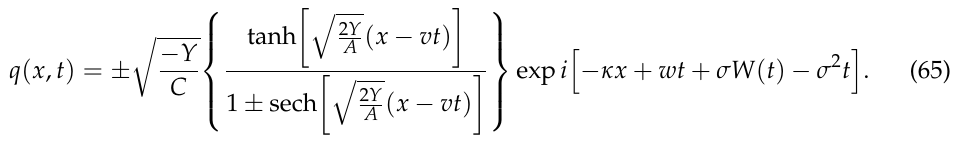
Figure 1: The numerical simulations of the solutions (17) 3D and 2D (with t = 1 the parameter values a 1 = 1, a 2 = 1, b = 1, σ = 0, α = 1, κ = 2, w = 2, λ = 1, µ = 1, c = 5, v = 3, 5 5. x , t − ≤ ≤